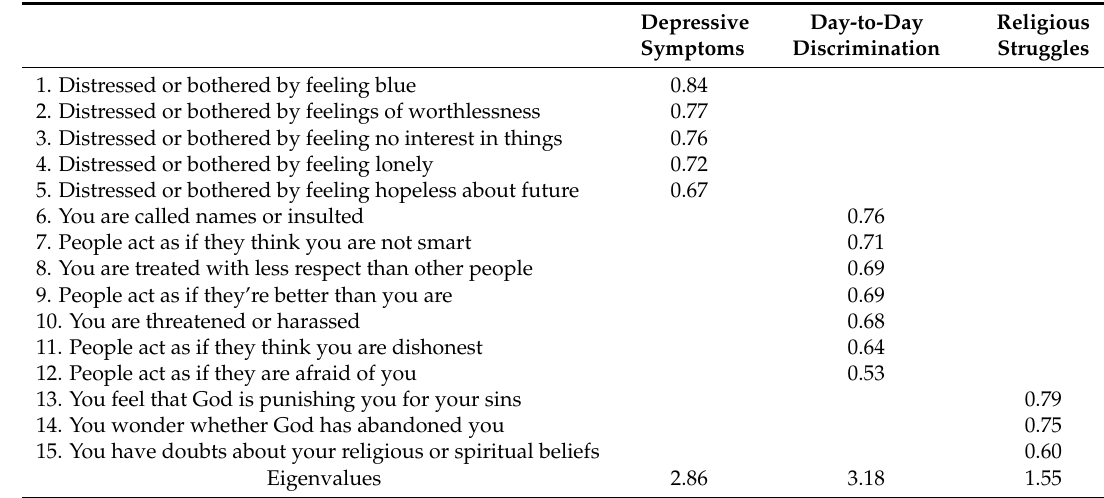
Table 1. Items and Component Loadings for Focal Measures ( n =